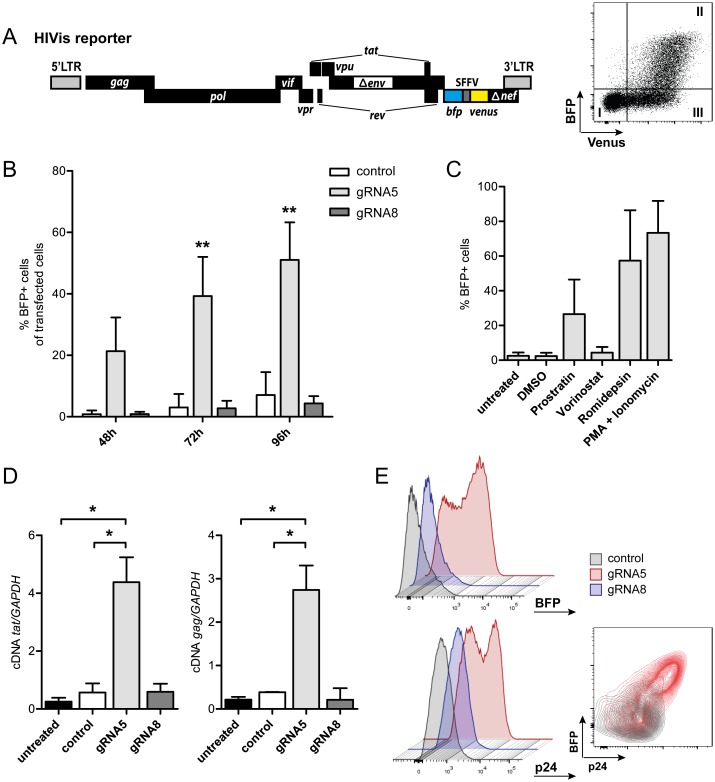
Latency reversal using SAM in the HIVis model system.(A) Scheme of replication incompetent HIVis latency reporter virus (left panel). Transcriptional activation results in LTR-dependent BFP expression, while the SFFV promoter drives constitutive expression of Venus fluorescent protein. Upon transduction of Jurkat cells with HIVis reporter, cells with active LTR transcription (II: BFP+, Venus+) can be distinguished from cell populations with a silenced LTR (III: BFP-, Venus+) or non-transduced cells (I: BFP-, Venus-) by flow cytometry (right panel). (B) Components of the SAM system together with gRNA5, gRNA8 or no gRNA (control) were transiently expressed in clonal HIVis cells (HIVisB2). Proviral activation was monitored by flow cytometry at 48, 72, and 96 h post transfection. Two-way ANOVA was used for statistical evaluation (in relation to control); ** signifies p<0.01. (C) Proviral activation levels in HIVisB2 cells after 24 h exposure to different latency reversing agents. (D) Levels of cell-associated tat and gag RNA in HIVisB2 cells as measured by qRT-PCR at 72 h post transfection with SAM system components plus gRNA5, gRNA8 or no gRNA (control). One-way ANOVA was used for statistical evaluation; * signifies p<0.05. Shown are results of three (B, C) and two (D) independent experiments. (E) Number of HIVisB2 cells showing BFP expression (upper panel) and cell-associated p24 expression (lower panel) at 72 h post transfection with SAM system components and gRNA5, gRNA8 or no gRNA (control). Insert shows a flow cytometry contour plot of p24 and BFP co-expression in control (grey) and SAM/gRNA5 transfected (red) cells.